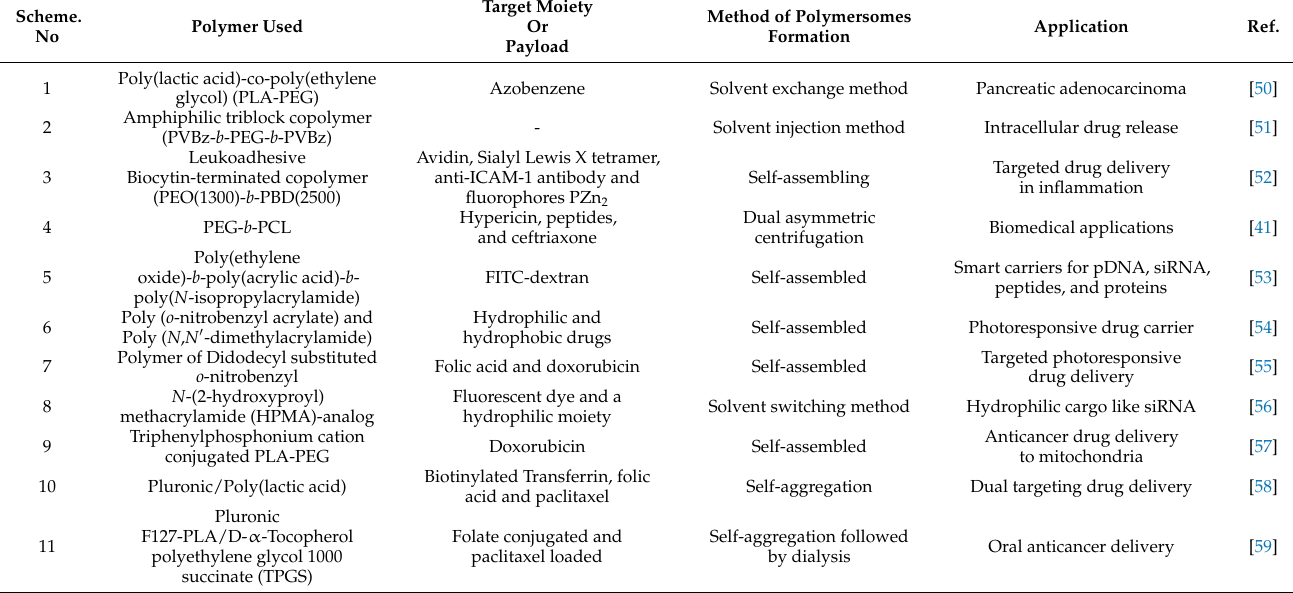
Table 1. Complies with recent advancements in polymersomes for drug delivery